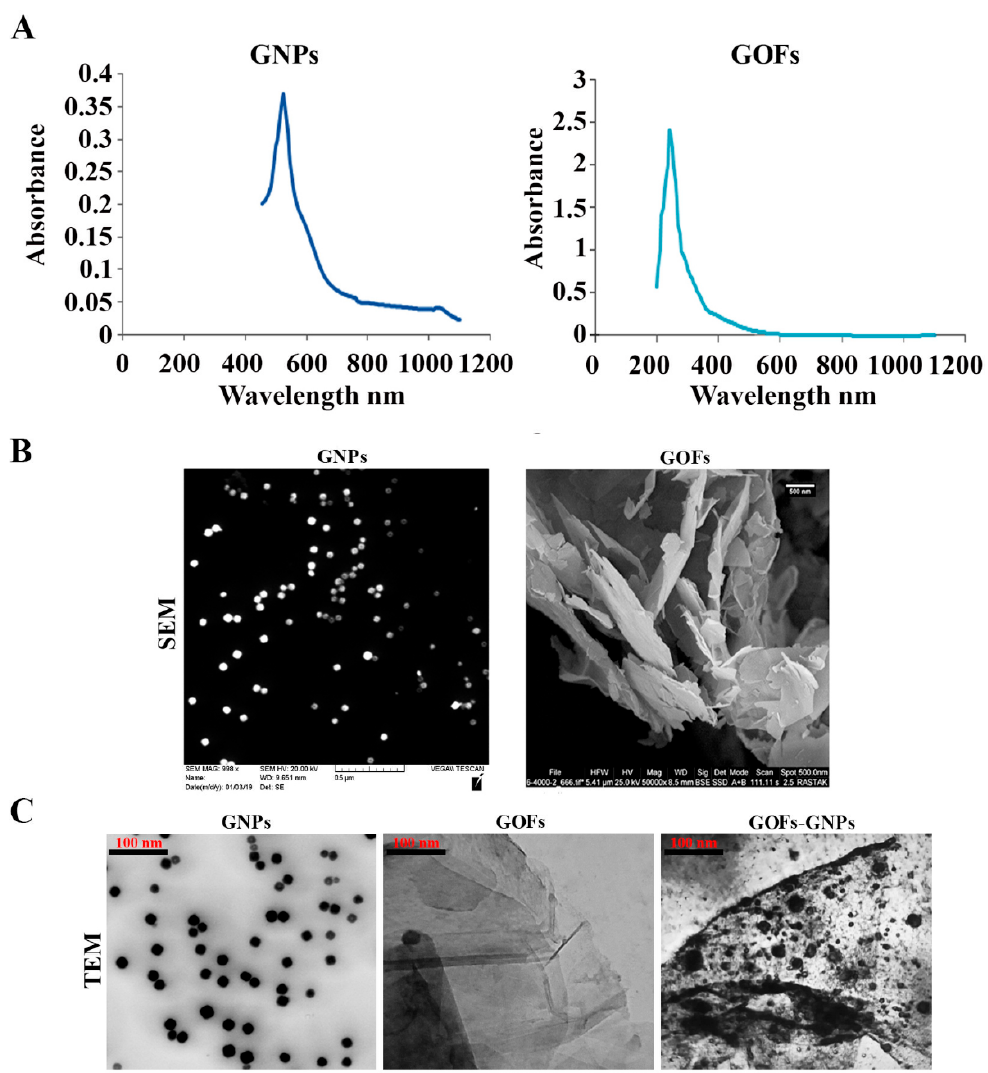
Figure 1. ( A ) UV-VIS spectroscopy analysis and ( B ) Scanning Electron Microscope (SEM) images of gold nanoparticles (GNPs) and graphene oxide flakes (GOFs); ( C ) Transmission Electron Microscope (TEM) images of GNPs, GOFs (exfoliated, single-layer sheets), and a mixture of GNPs and GOFs.